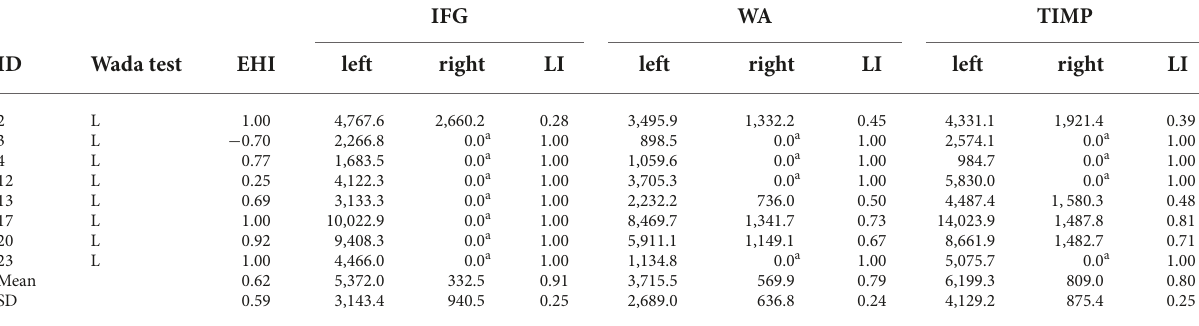
TABLE 3 MEG sum of thresholded and cluster corrected t -values in left and right ROIs and laterality indices in patients with left language dominance revealed by Wada test. IFG WA TIMP